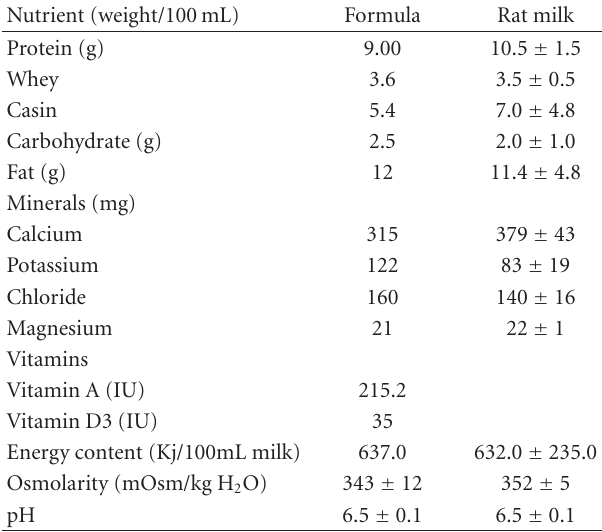
Table 1: Nutrient composition and physical properties of rat’s